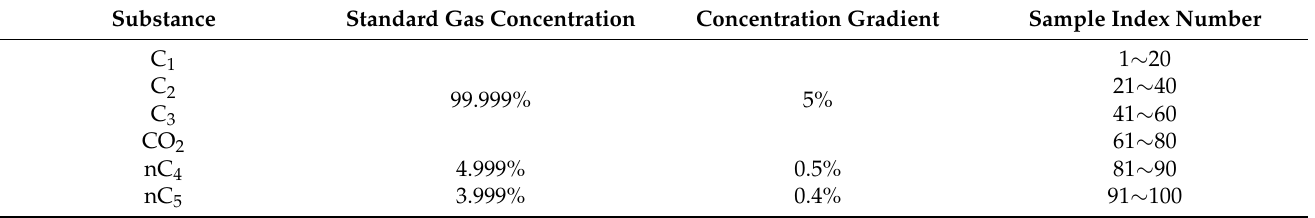
Table 1. Standard concentration and sample concentration distribution of the one-component